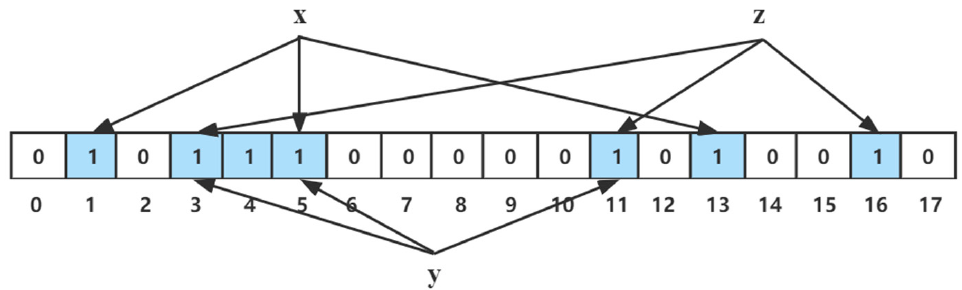
Figure 11. The process of hash mapping of BF.